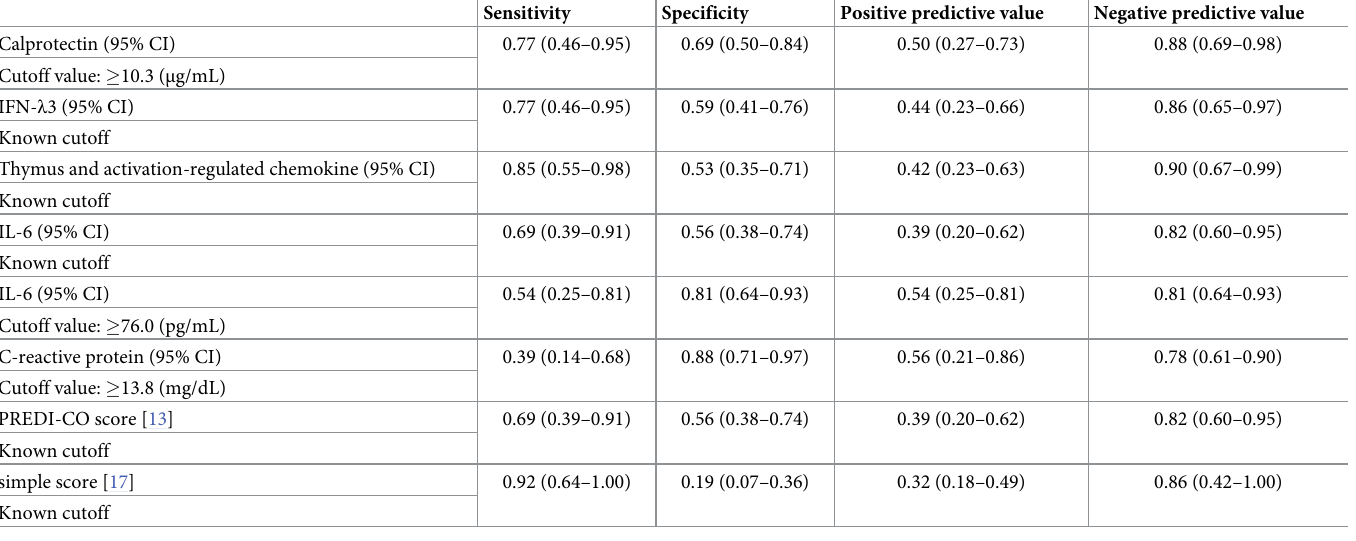
Table 4. Predictive ability of each biomarker and prediction score for future mechanical